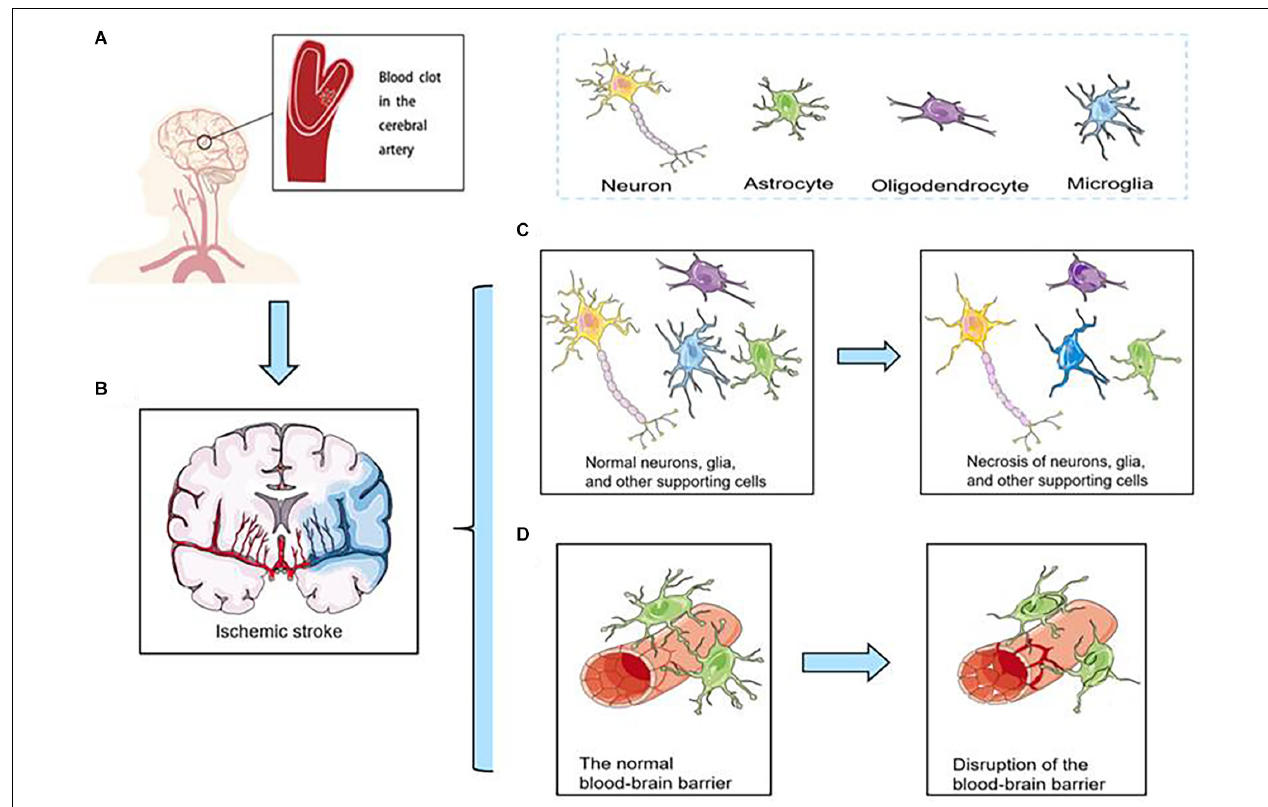
FIGURE 1 | (A) Ischemic stroke is caused by abrupt blood vessel occlusion. (B) Ischemic stroke initiates a cascade of secondary injury mechanisms in hypoperfused tissue. (C) Necrosis of neurons, glia, and other supporting cells. (D) Disruption of the blood-brain barrier